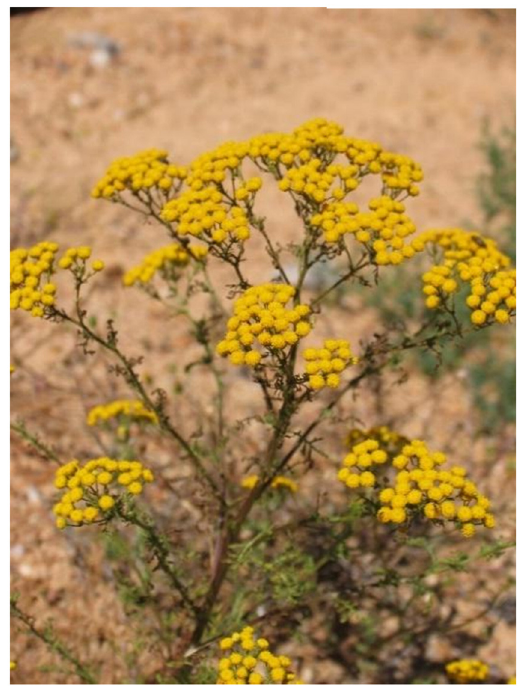
Figure 3: Oncosiphon su ff ruticosum ( Source: Anthony Magee )